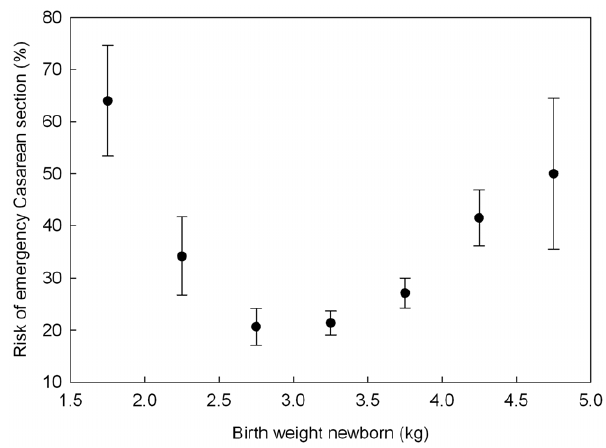
Figure 1. The effect of birth weight (means and 95% confidence intervals of raw data) on the risk of ECS. Birth weight in bins of 0.5 kg and bins lower than 2.5 and higher than 4.5 kg were pooled. The confidence interval was determined using the Agresti-Coull method [43].